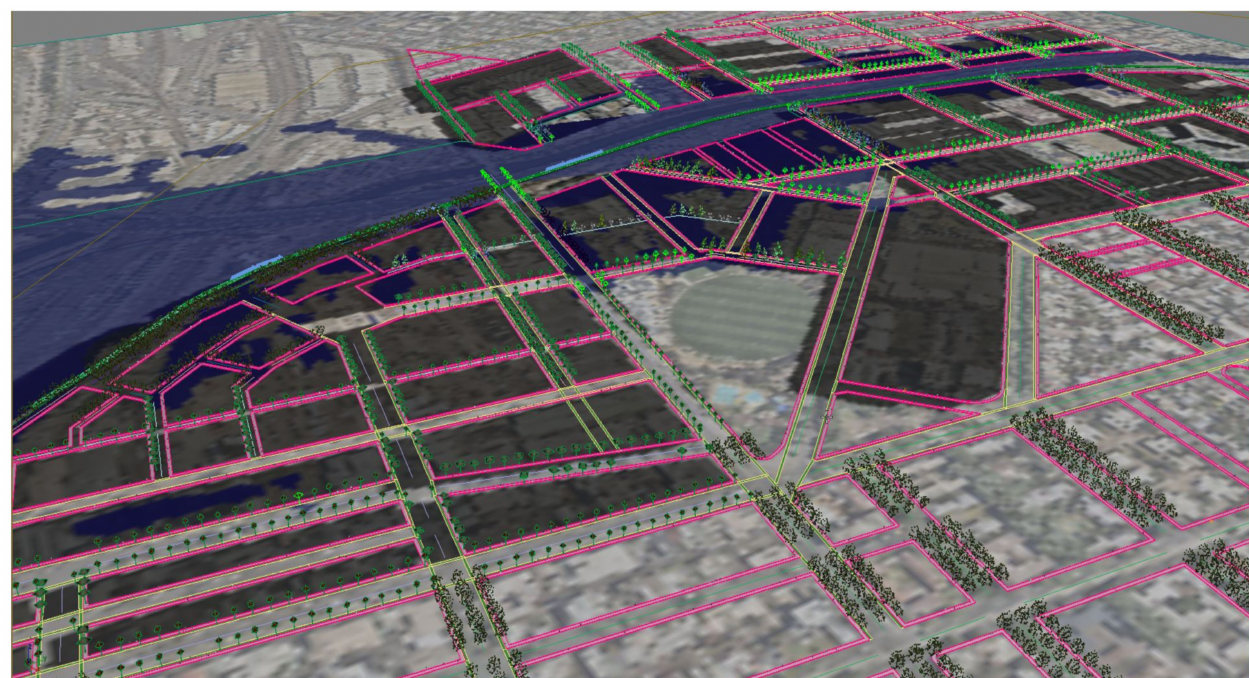
Figure 11. Aerial view screen grab the presence–absence mapping tree choice approach applied to the whole of the Arden-Macaulay site study scenario 1 ‘Land subject to inundation’ showing tree geometry model species placement responding to flooding conditions (in flood or not in flood) and shade conditions (in shade or not in shade). Tree models are displayed as simplified to point-clouds and simple shapes for computational efficiency. Image by authors using multi-criteria street